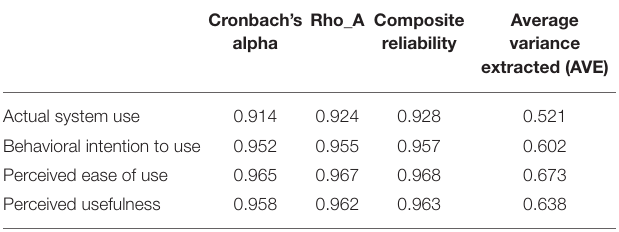
TABLE 2 | Cronbach’s alpha, composite reliability, and average variance extracted (AVE).